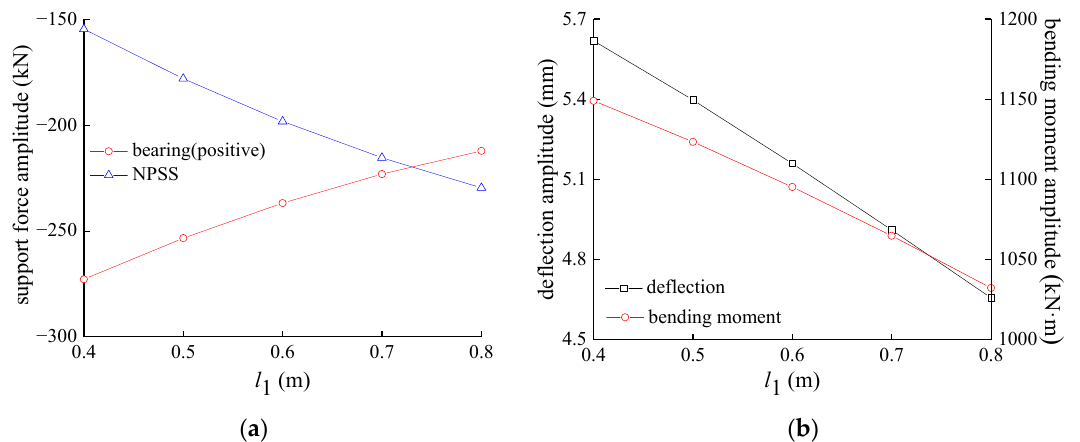
Figure 15. Envelope graph of the bending moment for various levels of k 2 / k 1 .